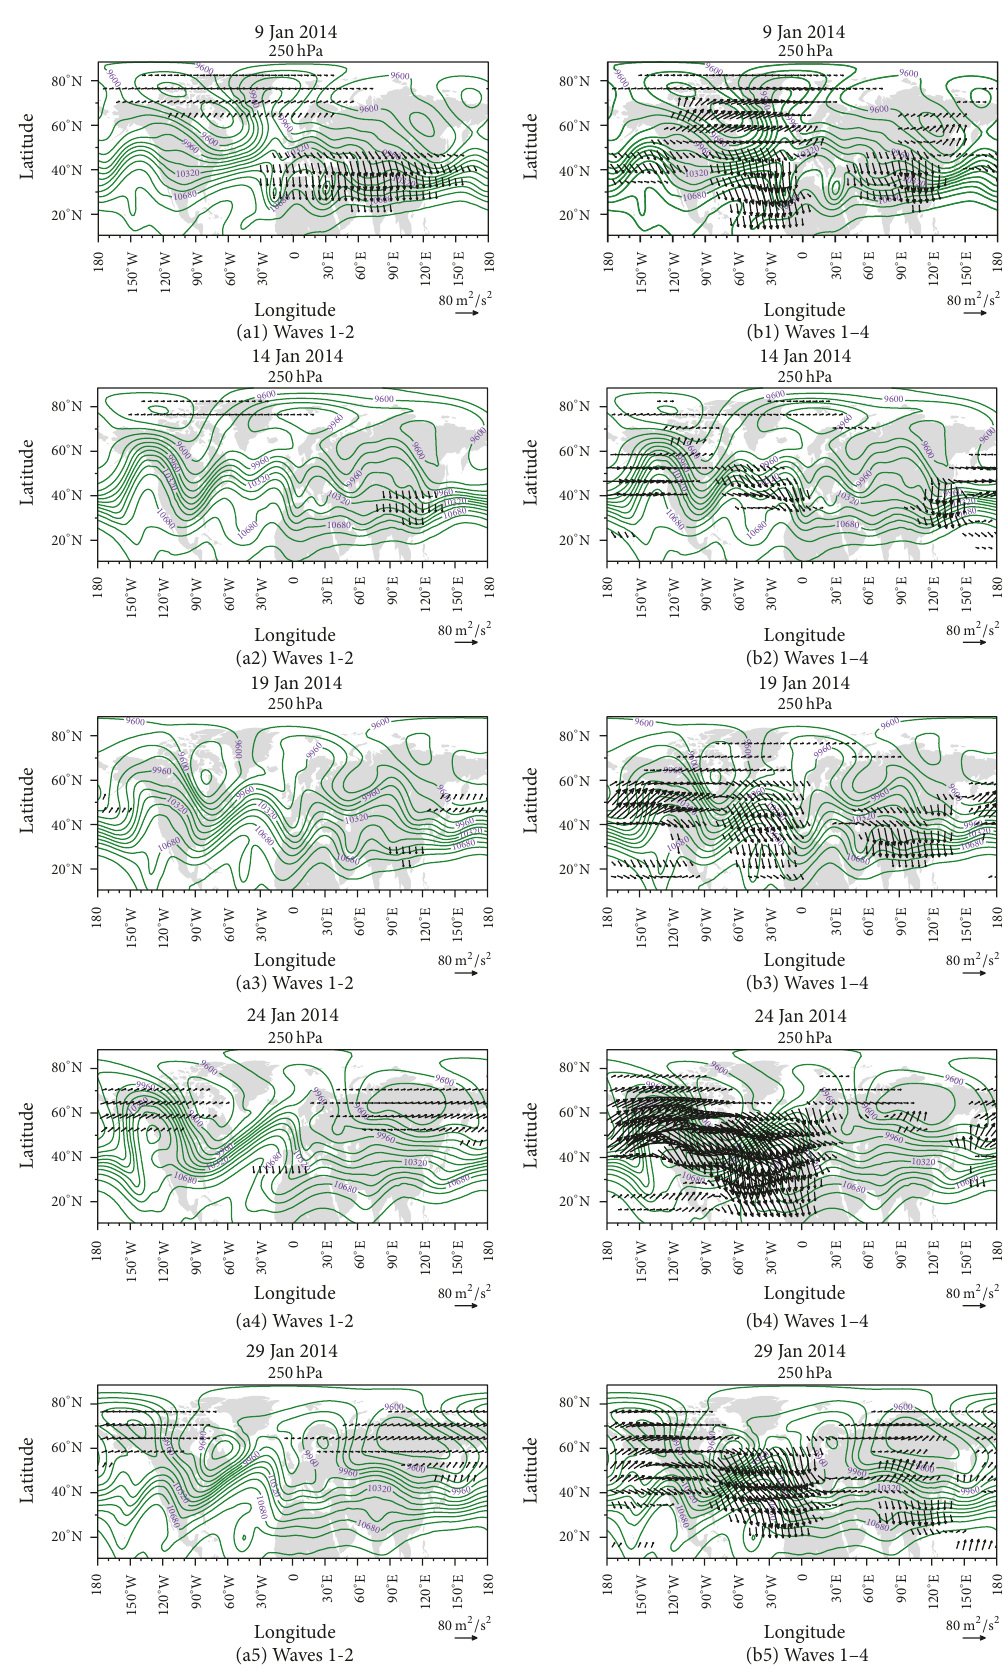
Figure 7: Daily geopotential height (contours; m) and WAFs (vectors: > 12m 2 s −2 only) of PWs 1 and 2 ((a1)–(a5)) and waves 1–4 ((b1)–(b5)) at 250 hPa in January 2014. Contour interval: